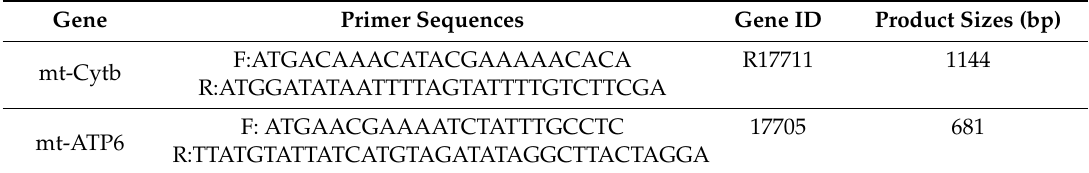
Table 3. Primer sequences and their corresponding PCR product sizes for mutations of mt-Cytb and